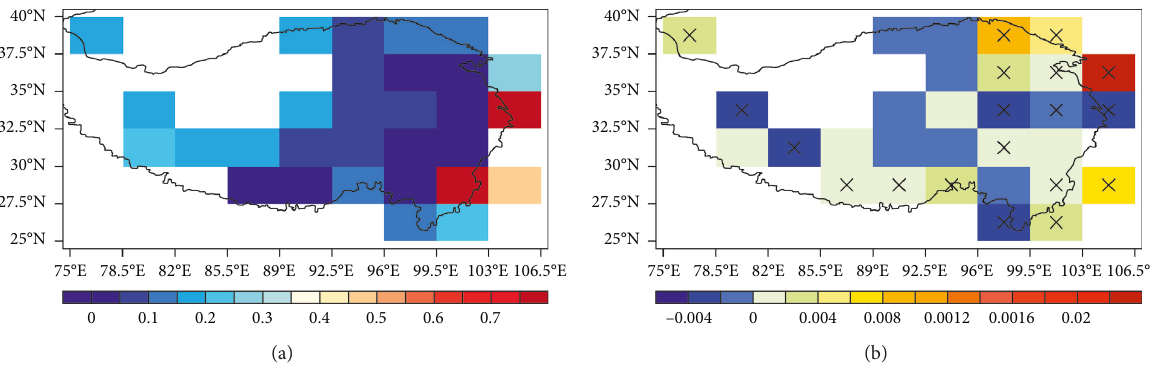
Figure 7: Spatial distribution (a) and linear trend (b) of annual mean sampling error variances calculated from reanalysis data on the TP averaged over